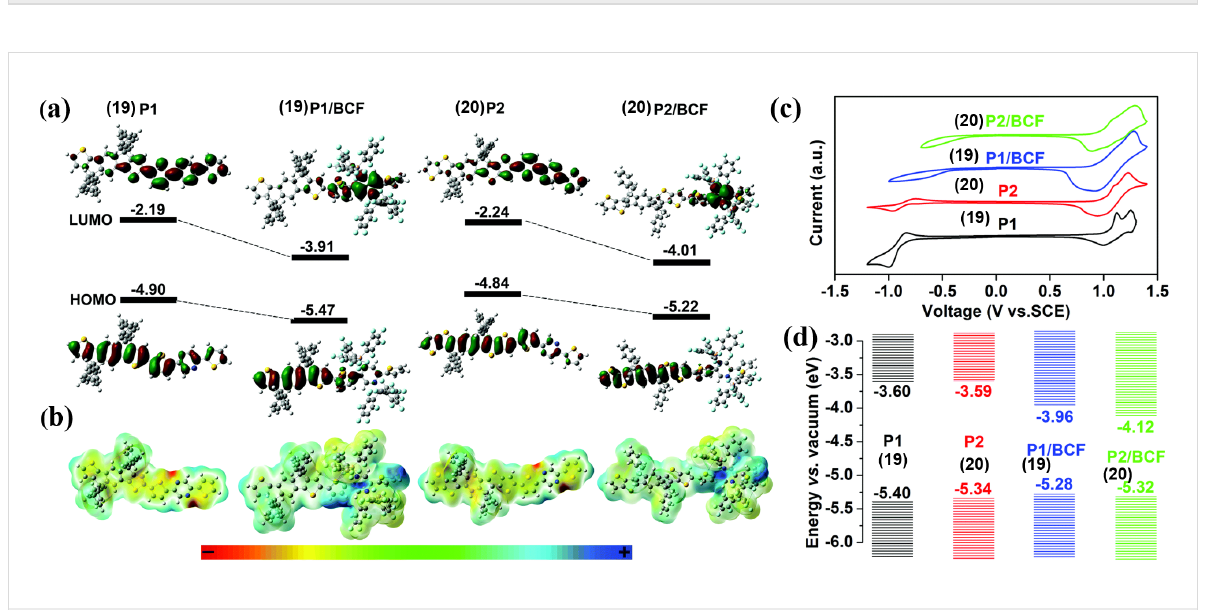
Figure 11: (a) HOMO/LUMO orbitals and energy levels (unit: eV) and (b) electrostatic potential surface (EPS) maps calculated by Gaussian 09 at the B3LYP/6-31G(d,p) level of theory. (c) Cyclic voltammetry curves of the four compounds and HOMO/LUMO energy level diagram and (d) estimated from the CV tests. Figure 11a–d were reproduced from [45] with permission from The Royal Society of Chemistry. This content is not subject to CC BY